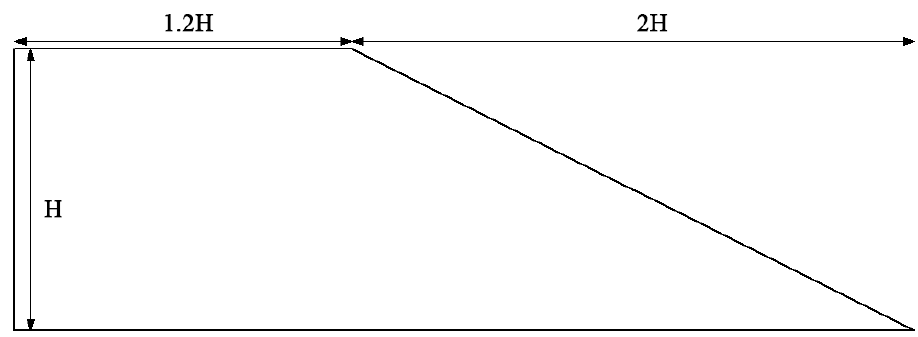
Figure 6. Slope dimension diagram of an example studied after [50].